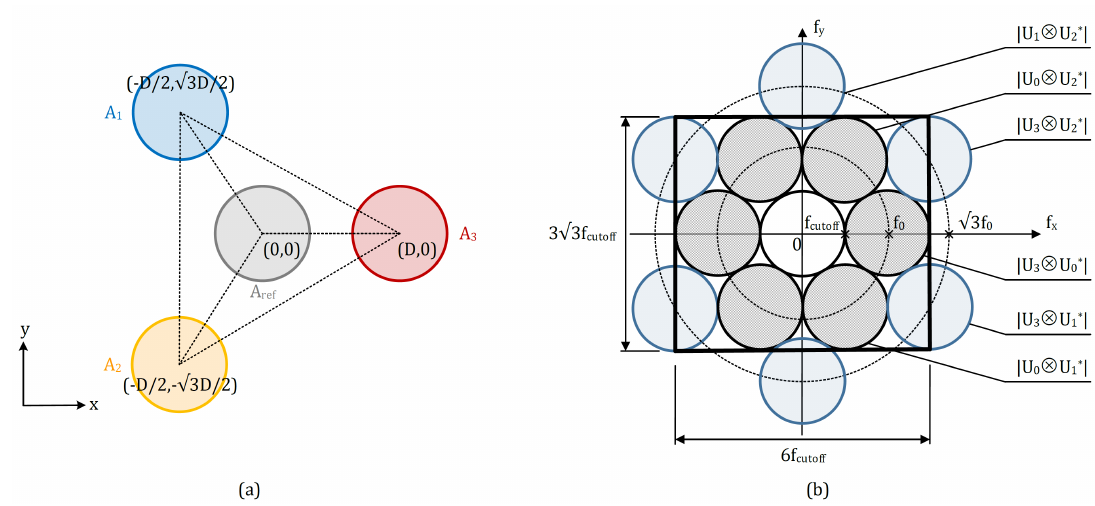
Figure 5. ( a ) relative positions of the virtual images of the four single apertures in the detector’s plane; ( b ) spectra distribution of the internally modulated speckle interferogram with respect to ( a